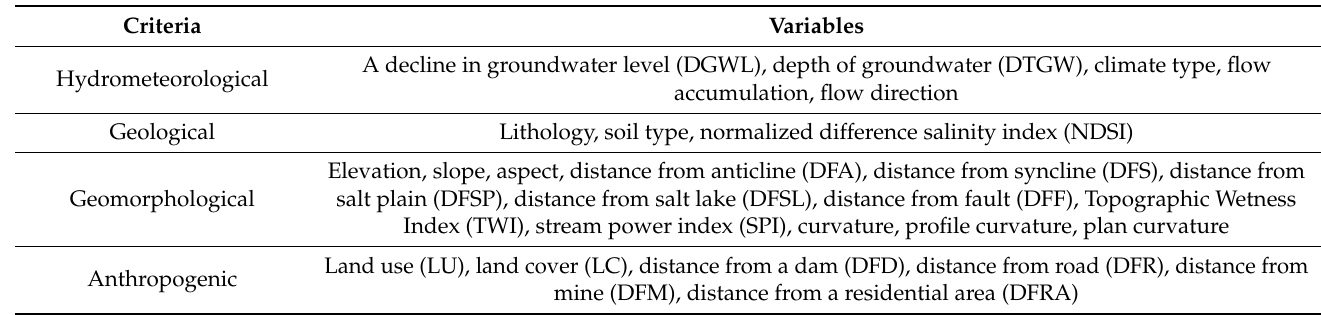
Table 1. Variables in land subsidence (LS) susceptibility